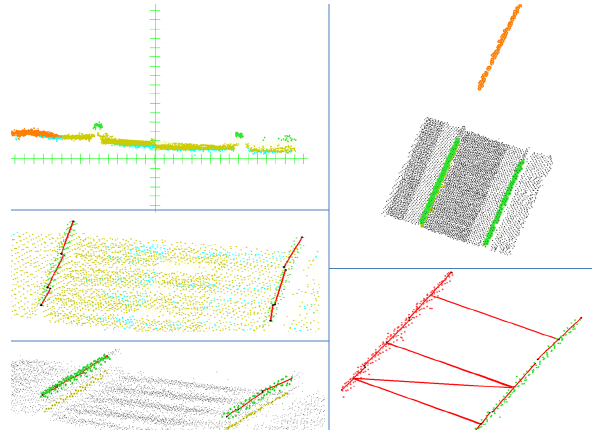
Figure 3 Detection steps for rail tracks: rough classification of terrain points after step 1 (upper left, green are potential rail track points, cyan are points lower than the DTM height, yellow are other points within a grid cell with rail points, orange are points in a grid cell without rails or wires). Middle left: result after RANSAC line fitting (step 2). Lower left: including points (yellow) within 0.12 m of fitted line. Upper right: filtering step by keeping only rail track points (green) within a certain distance of wire points (orange) (step 3). Lower right: red lines indicate which fitted lines are parallel with a perpendicular distance between 1.4 and 1.6 m (step 4). Red points are on one side of the track, green at the other side.